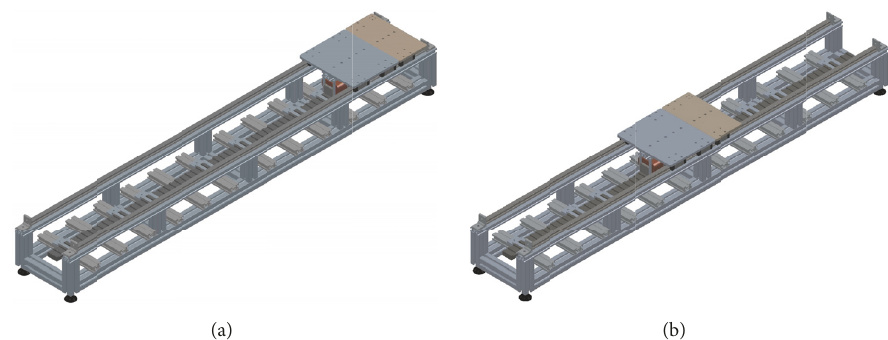
Figure 5: An example of the LSRA configurations regarding the positions of the platforms: (a) at P1, thus aligned at the rightmost end; (b) at P3, aligned with the symmetry axis (base and